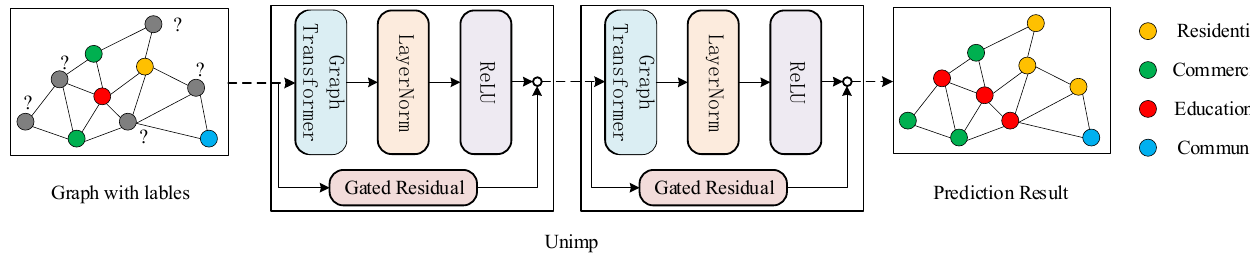
Figure 2. The framework of building function classification by UniMP.